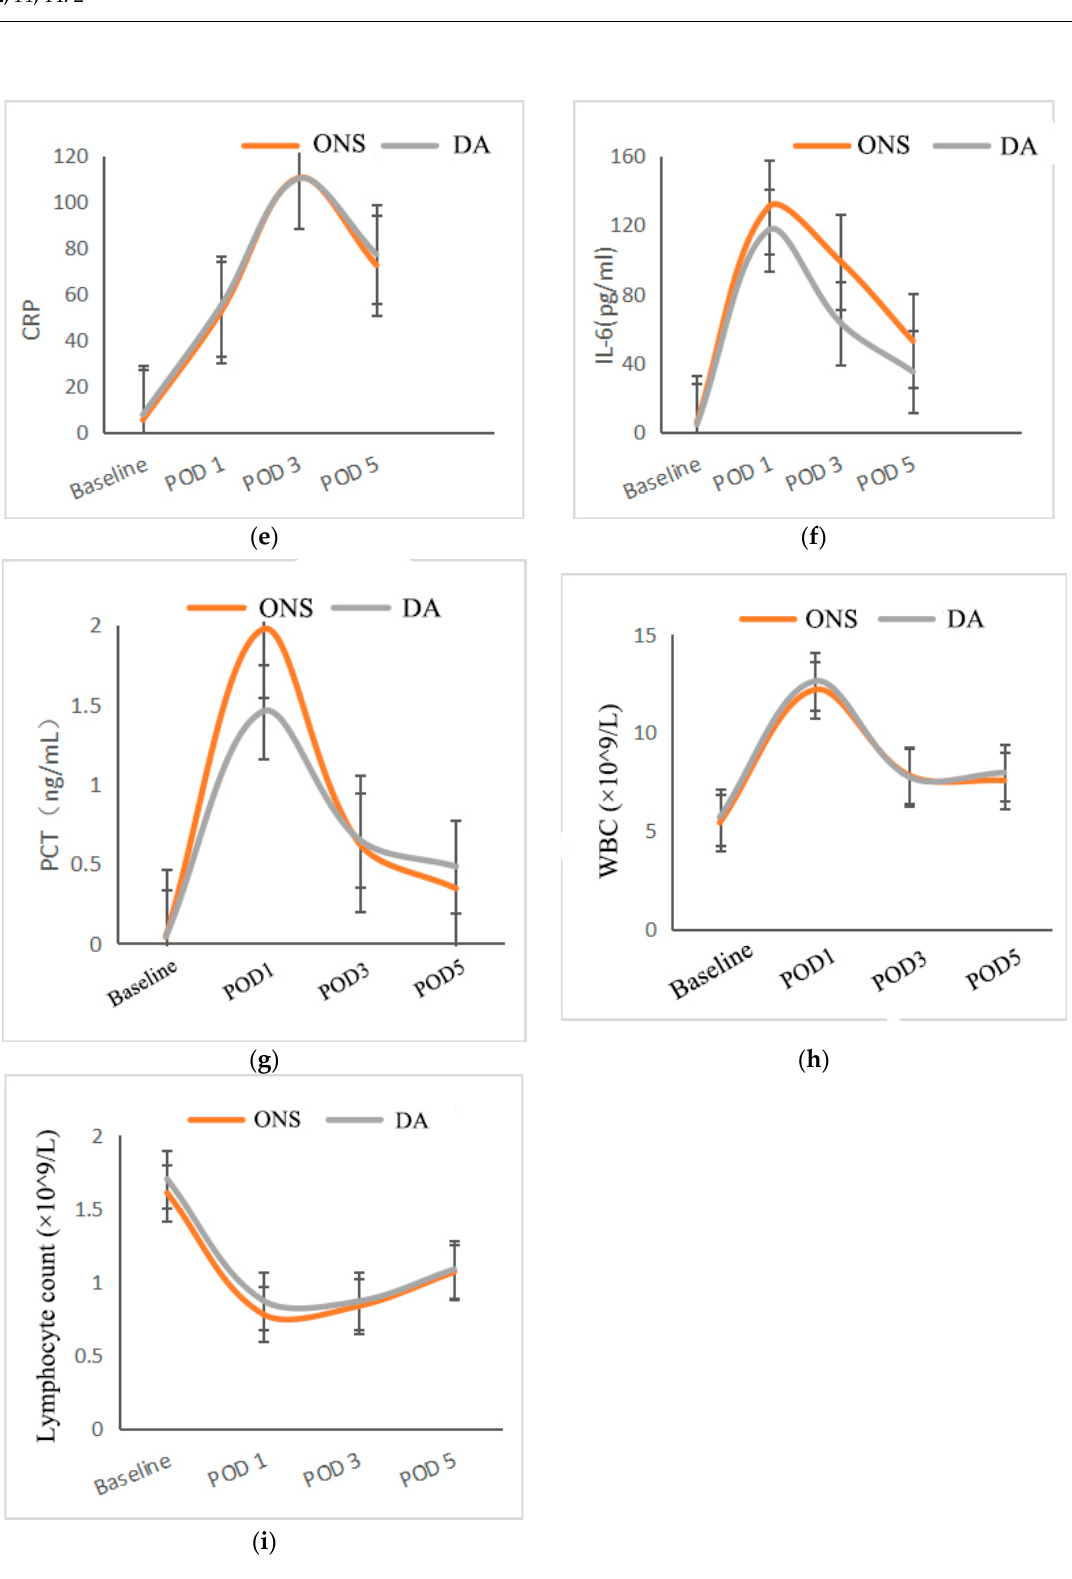
Figure 3. Changes in serological indicators. ( a ) Perioperative blood glucose fluctuation. ( b ) Perioperative prealbumin (PAB) fluctuation. ( c ) Perioperative fluctuation of serum total albumin (TB). ( d ) Perioperative serum albumin (ALB) fluctuation. ( e ) Perioperative c ‐ reactive protein fluctuation (CRP). ( f ) Perioperative interleukin ‐ 6 (IL ‐ 6) fluctuation. ( g ) Changes in serum procalcitonin (PCT) levels during perioperative period. ( h ) Perioperative white blood cell (WBC) fluctuation. ( i ) Changes in Serum Lymphocyte Count.